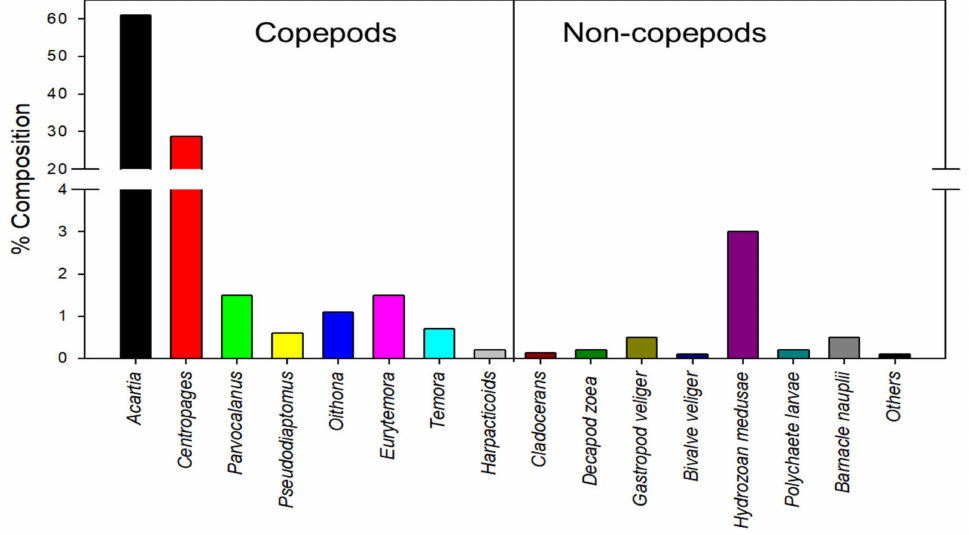
Figure 5. Mesozooplankton community composition in the Maryland Coastal Bays based on samples collected in 2012 and 2013.